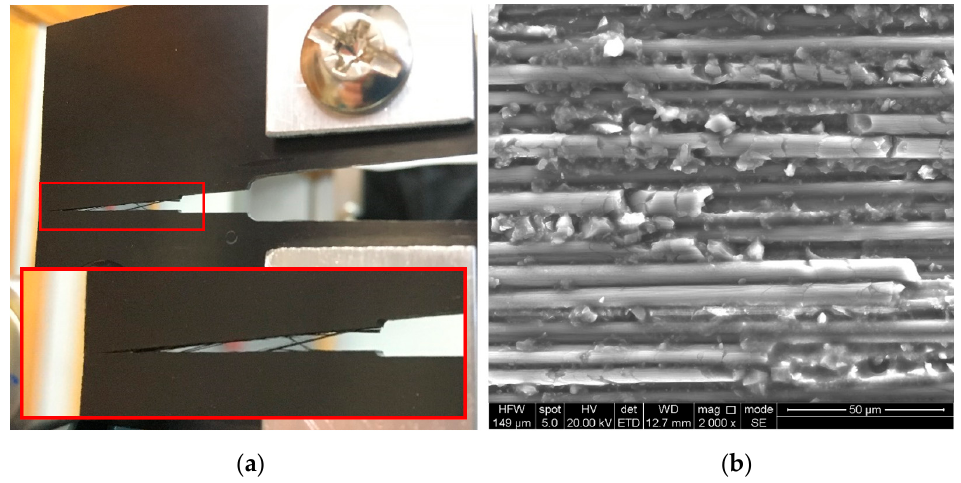
Figure 6. In situ photograph of the CT test of UCT specimens. ( a ) Detail of the fibre-bridging process; ( b ) SEM image of the fracture surface of a UCT representative specimen. ( b ) SEM image of the fracture surface of a UCT representative